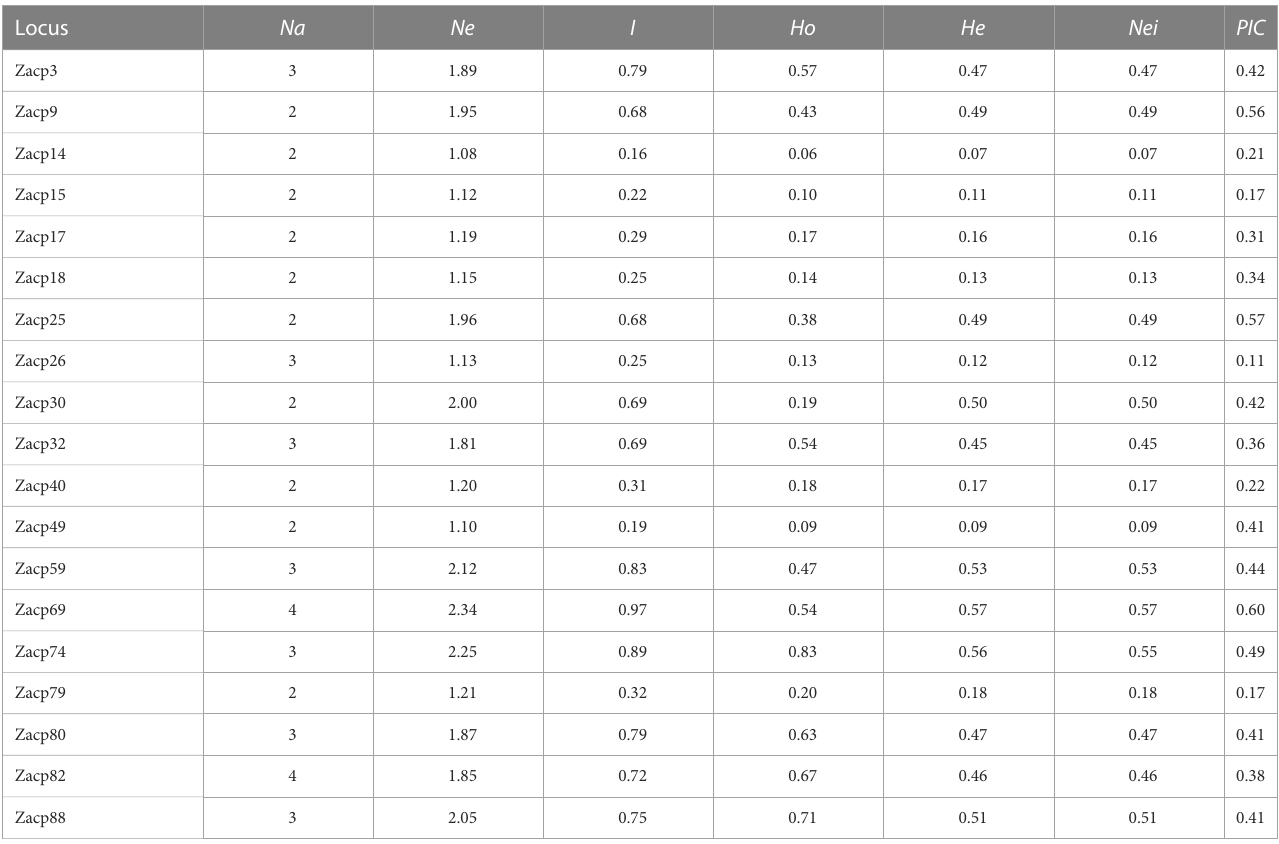
TABLE 1 Descriptive statistics of the 40 ESR-SSRs markers scored on 160 colored calla lily accessions. Locus Na